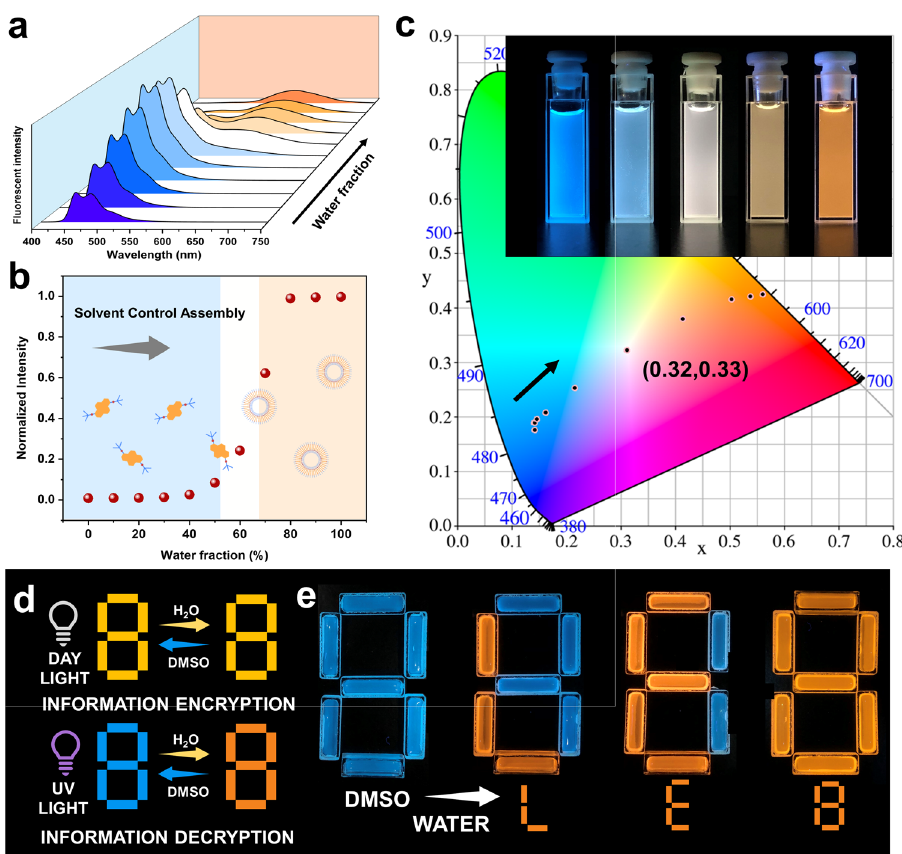
Fig. 4 A multicolour fl uorescence system controlled by tailoring the solvent composition. a The optical features of the emissive compound PY16 monitored by fl uorescence spectroscopy upon increasing the water content (from blue to orange), λ ex = 380 nm. b Recorded fl uorescence intensity changes in the excimer emission peak (600 nm) with different water fractions. c CIE 1931 chromaticity diagram of compound PY16 with a steadily increasing water fraction. Inset: fl uorescence images of PY16 in DMSO/H 2 O mixtures with different water fractions under UV light exposure, λ = 380 nm. d A schematic illustration of the information encryption-decryption process. e Fluorescence images of multiple pieces of information made ex from PY16 solution and written by adding